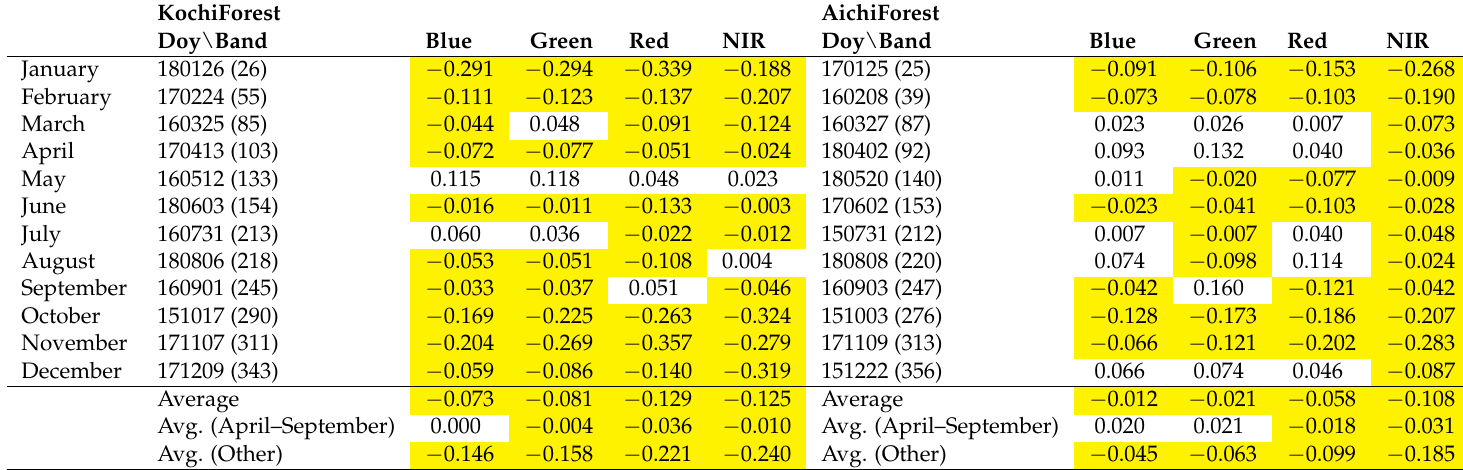
| − | 1 − r | for the two forest ROIs. Negative values indicate a better performance of the RAM method than the SZM method. Table 7. Summary of | 1 − r j j SZM RAM